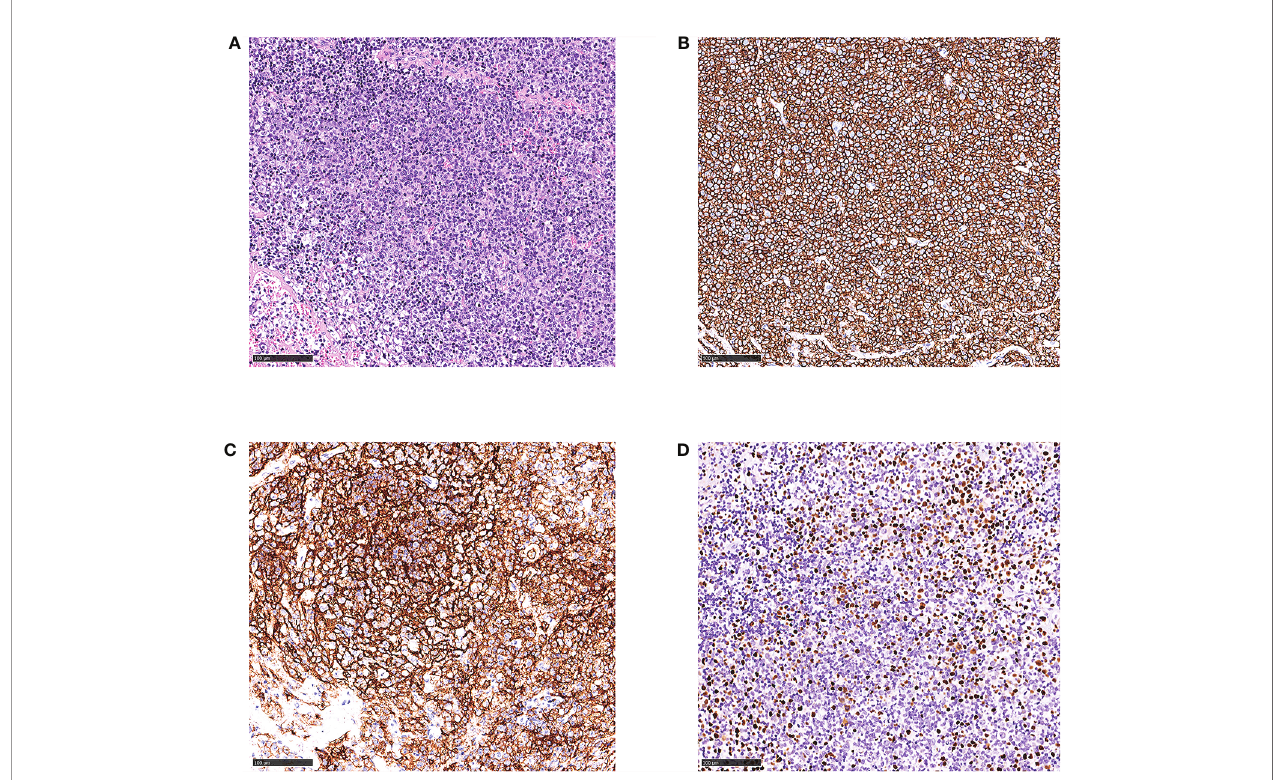
FIGURE 1 | Histological and immunophenotypic results of excisional biopsy of left cervical lymph node. Hematoxylin and eosin (H&E)-stained sections is seen (A) . Immunohistochemical staining of these specimens shows that the in fi ltrated lymphocytes are positive for CD20 (B) , CD21 (C) offollicular dendritic cells, and EBER (D) . (magni fi cation